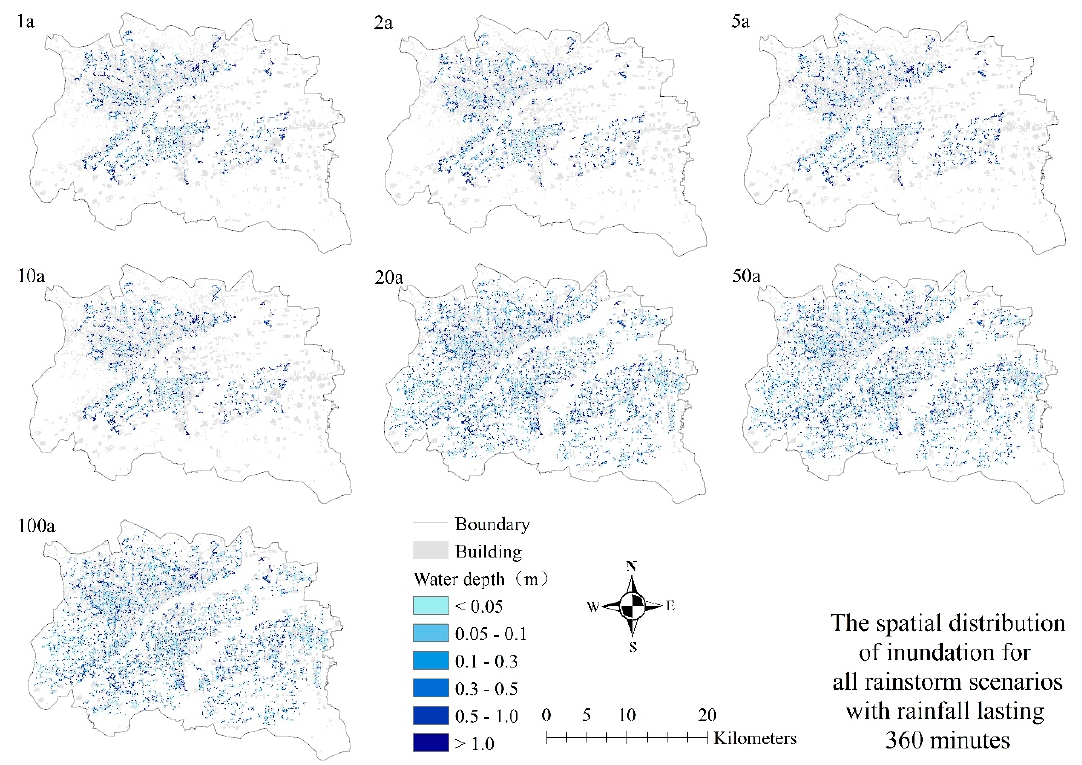
Figure 11. Spatial distributions of inundation for 360 min rainstorm scenarios.